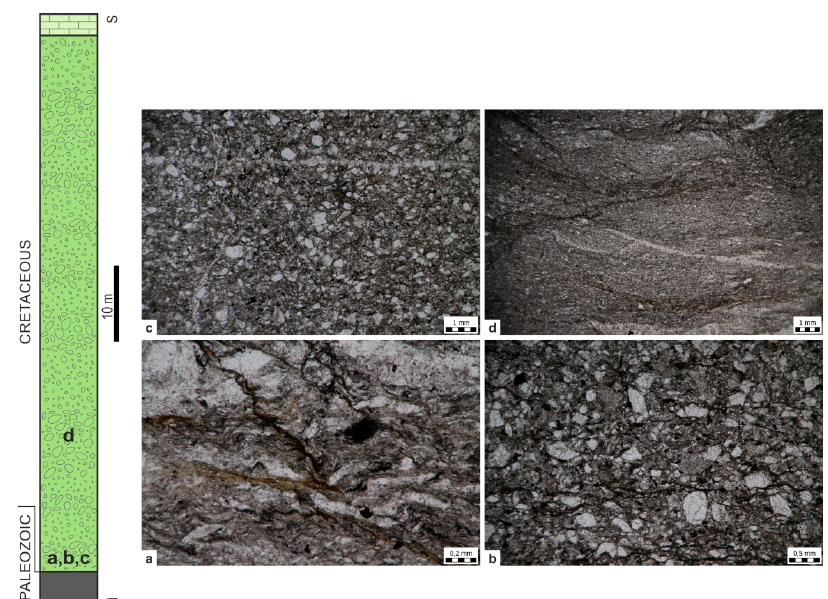
Figure 5. Photomicrographs of thin sections prepared from pebbles, in transmitted light: ( a ) fine-grained greywacke pebble in the base of the studied section, thin section M–0.1; ( b ) black slate pebble with visible relic cross-bedding texture; thin section M–1.3; ( c ) complex crenulate cleavage in a mylonitized greywacke, thin section M–1.3; ( d ) cleavage in greywacke pebble, with some rotated clasts, thin section M–6b. Position of Points marked on a schematic column.